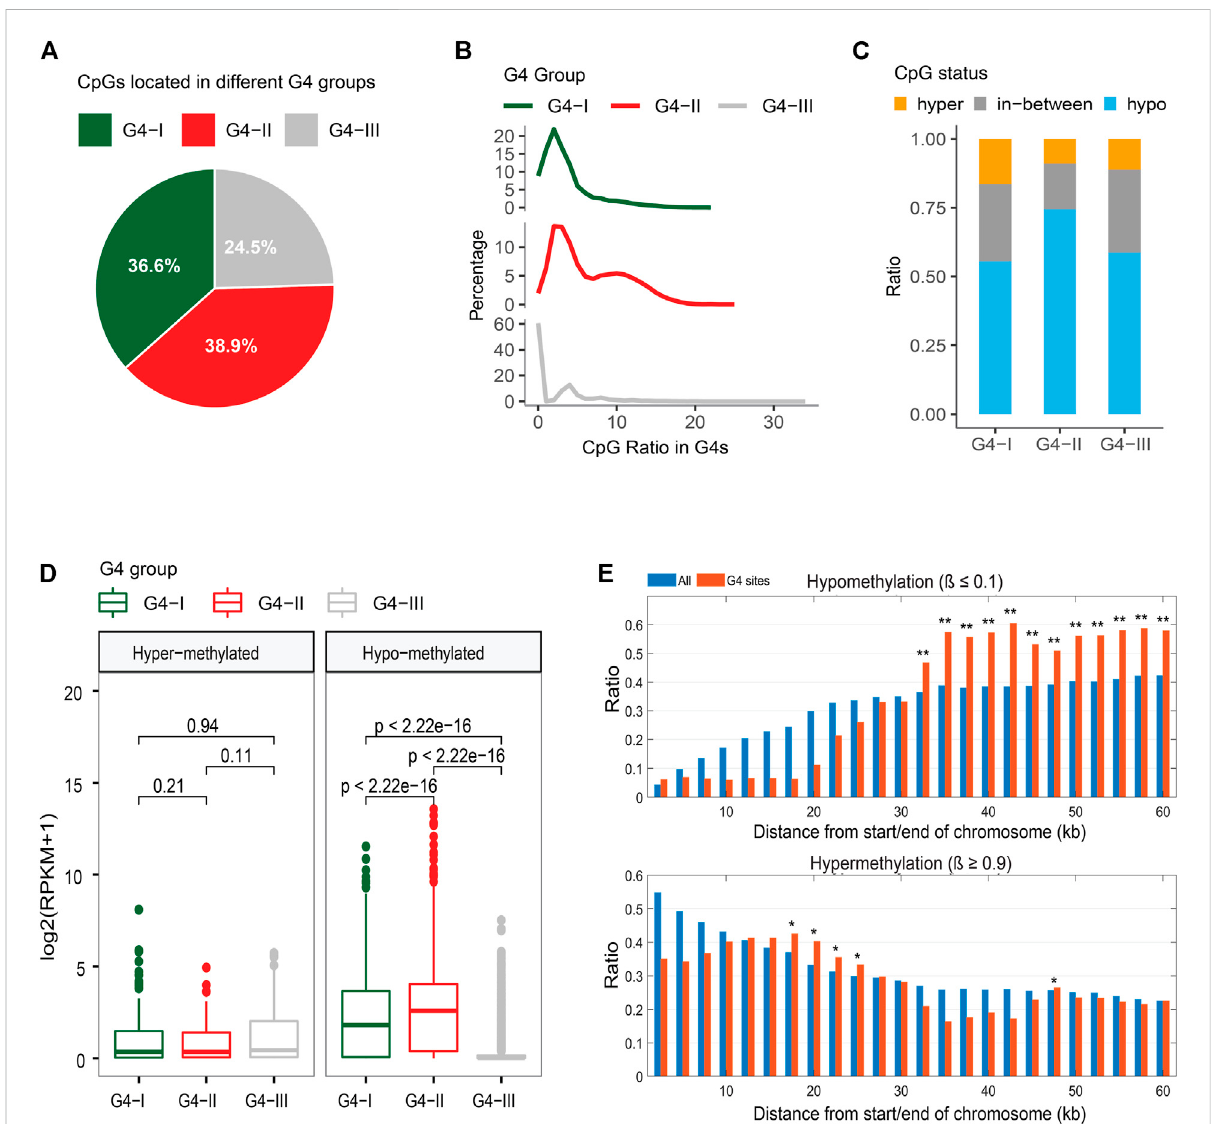
FIGURE 6 Relationship between G4 groups and DNA methylation. (A) Distributions of CpG sites locating in three G4 groups. (B) CpG density distributions in G4 groups. (C) Distinct CpG methylation levels in three G4 groups. (D) Expression levels of genes with upstream G4s containing only hypermethylated or only hypomethylated CpG sites. (E) DNA methylation patterns within or close to telomeres for all CpG sites and CpG sites covered by G4 sites